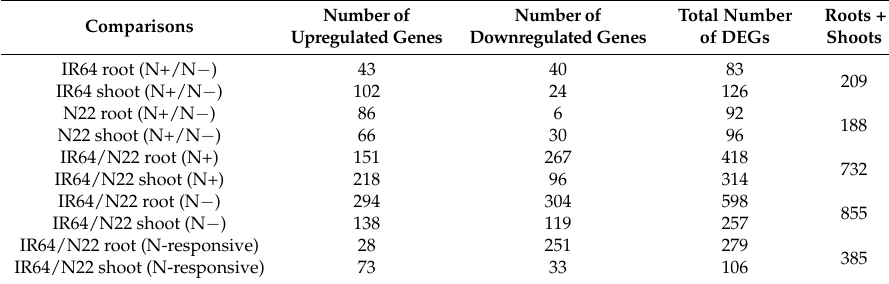
Table 2. Number of differentially expressed genes (DEGs) at p value ≤ 0.05, and log 2 fold change: within and between genotype comparisons for shoot and root tissues under optimal (N+) and low (N −